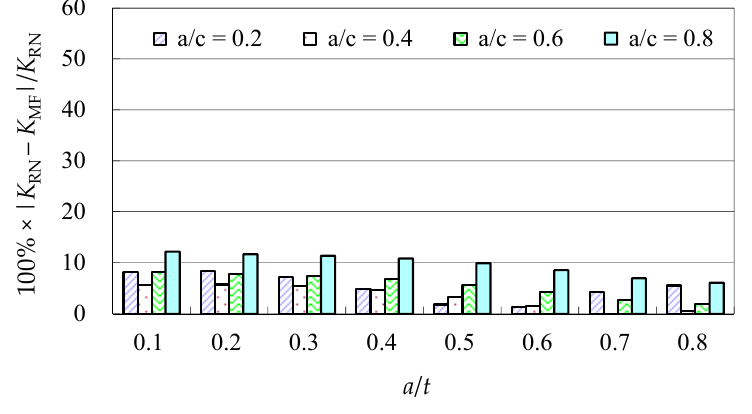
Figure 16. Modified formula vs. the Raju-Newman solution at point A ( c / W = 0.2).